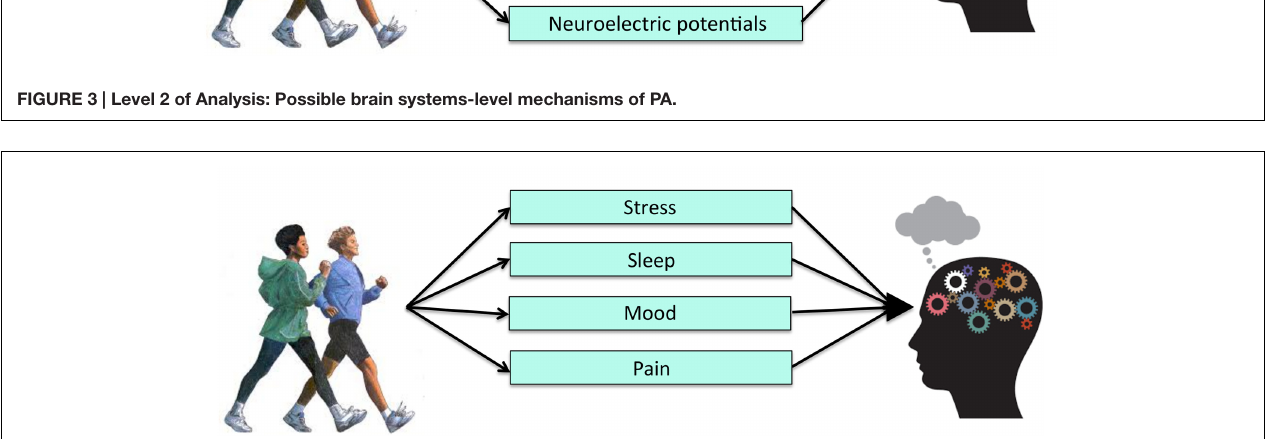
FIGURE 4 | Level 3 of analysis: Possible behavioral mechanisms of